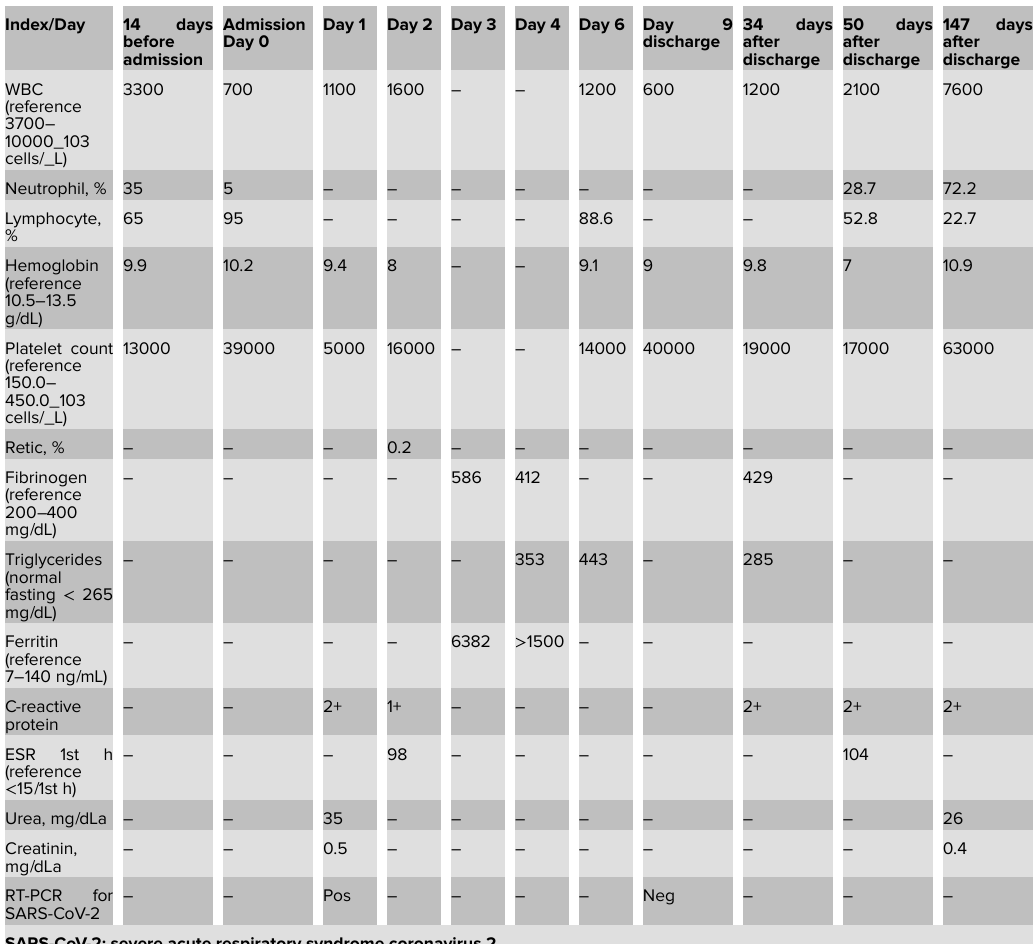
Table 1: Laboratory findings related to the